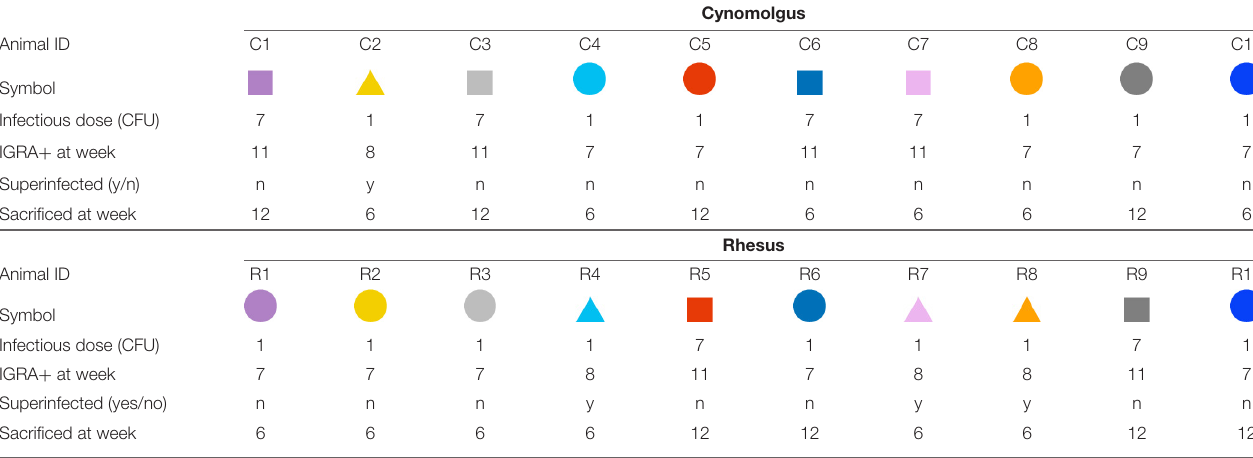
TABLE 1 | Infection characteristics after dose-escalation Mtb administration for each